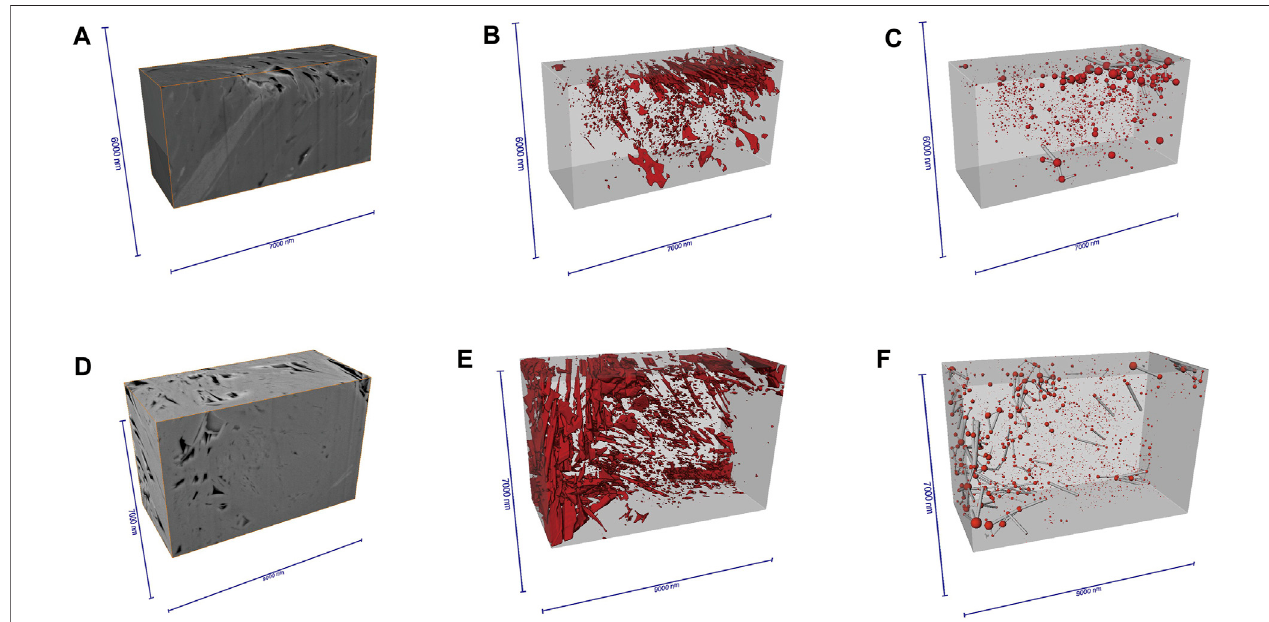
FIGURE 12 | Digital cores of shale and tight sandstone samples. (A) , (B) and (C) M5-2 well, black carbonaceous shale; (D) , (E) and (F) M5-7 well, Dark grey fi ne- grained detrital sandstone.